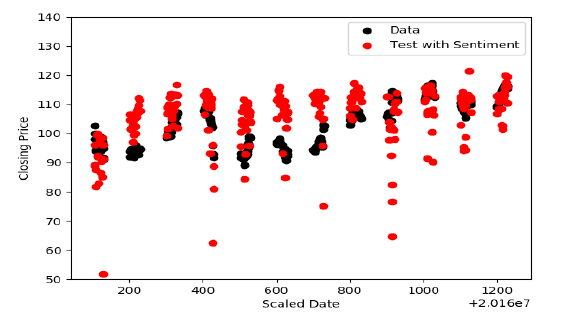
Figure 7. Values AAPL stock generated by the Perceptron network fitted on the actual values from 04-01-2016 to